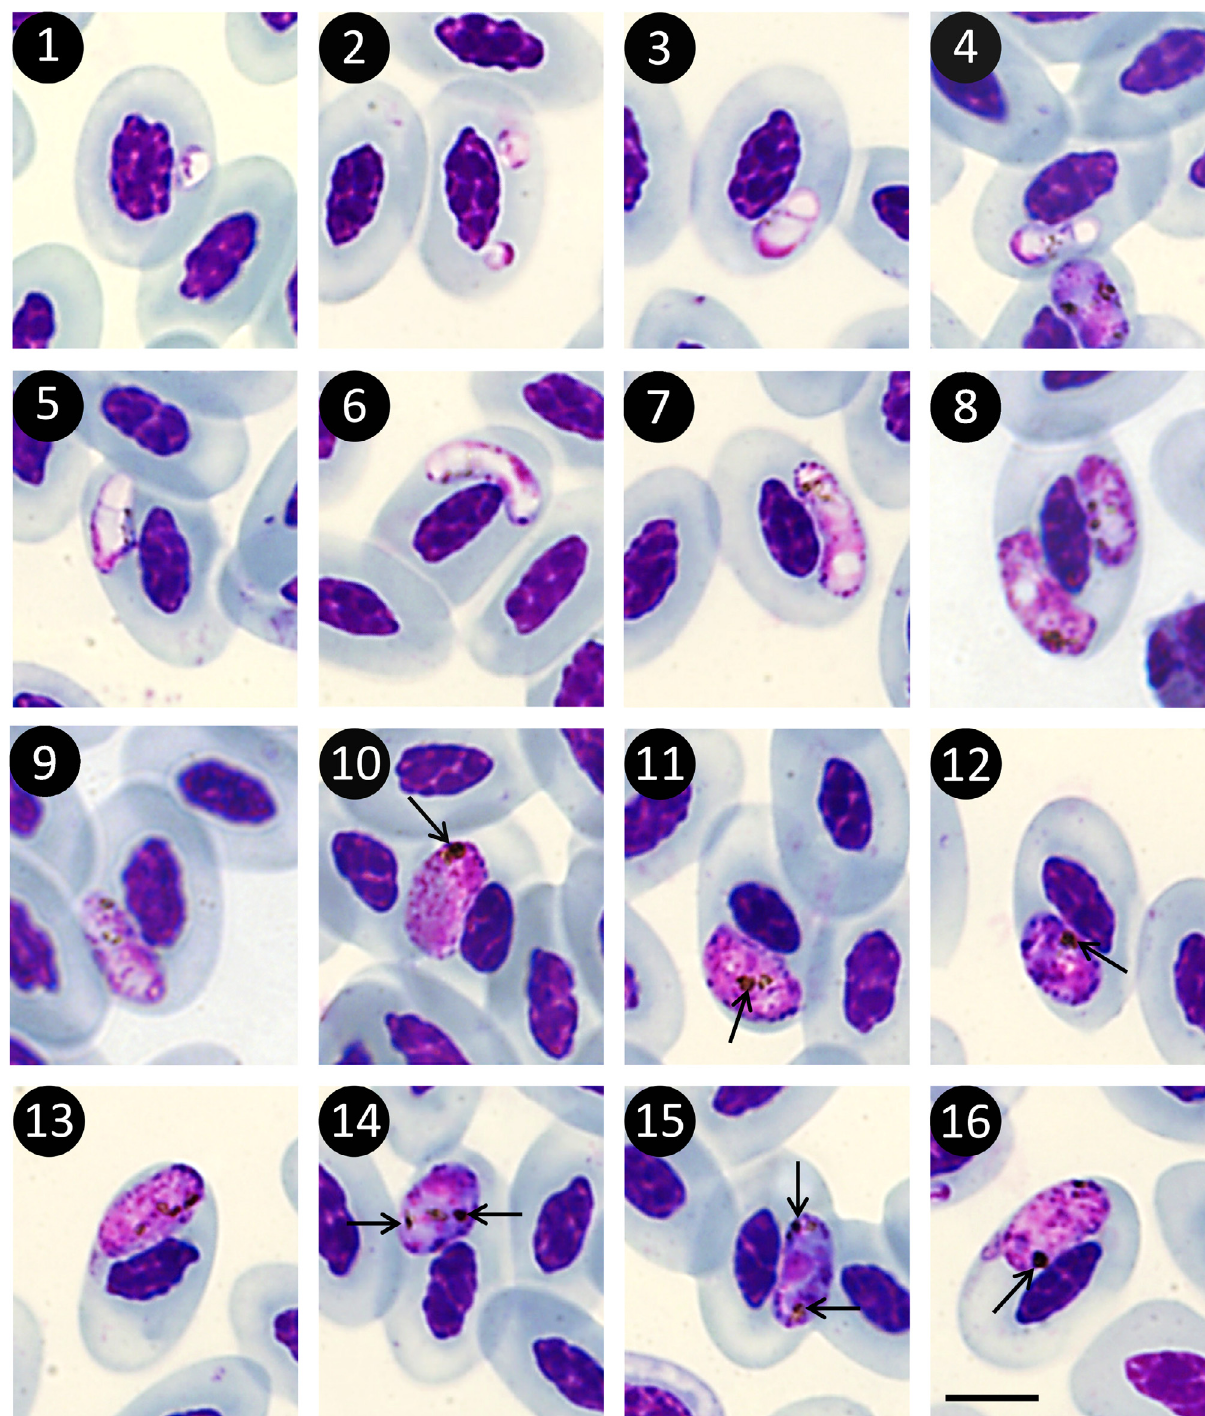
Figures 1–16. Microphotographs of gametocytes of Haemoproteus ilanpapernai Karadjian & Landau n. sp. in the blood of Strix seloputo . 1–5: Young gametocytes; 6 and 7: immature gametocytes; 8 and 9 : nearly mature gametocytes; 10 and 16: microgametocytes with agglomerated pigment (arrows); 11 and 13: microgametocytes with the erythrocyte nucleus tilted; 12: macrogametocyte with the erythrocyte nucleus tilted; 14 and 15: macrogametocytes with aggregation of pigment (arrows). Giemsa staining. Scale bar = 5 l